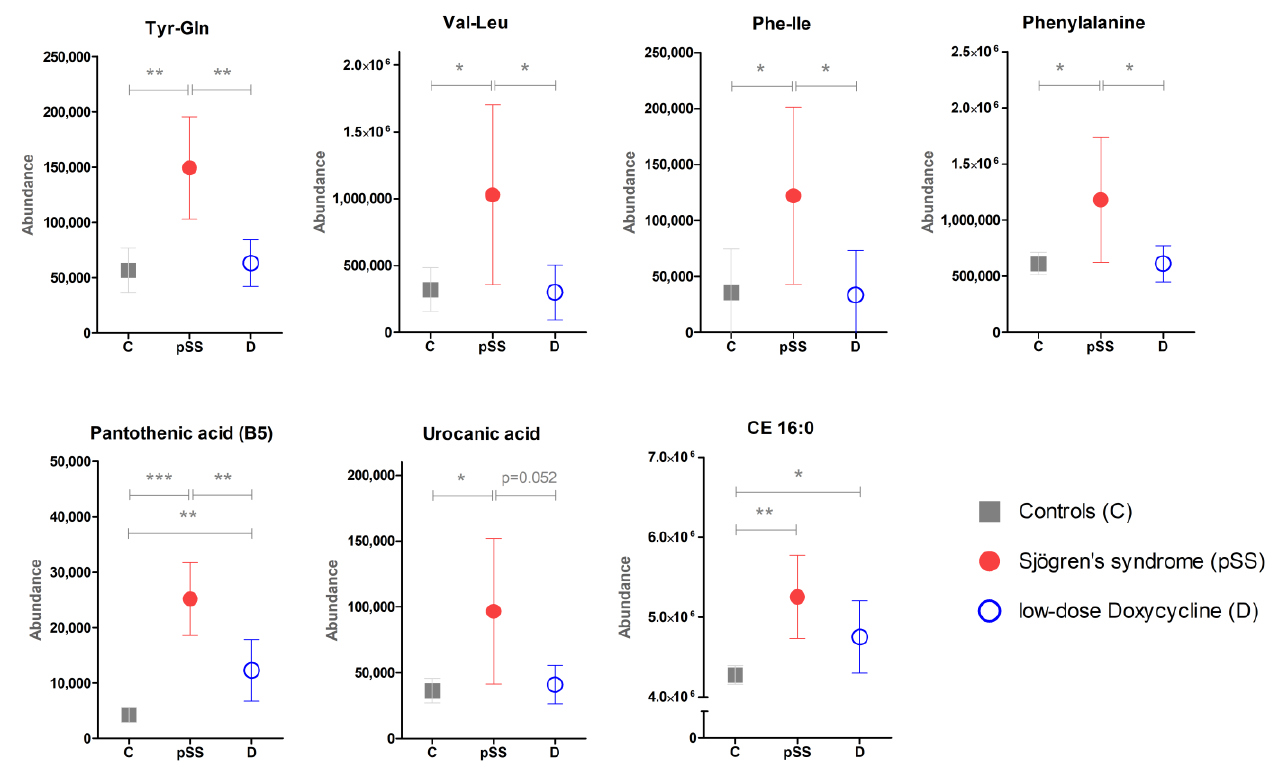
Figure 2. LDD treatment normalized levels of metabolites in the saliva samples of patients with Sjögren’s syndrome. Several metabolites were altered in the saliva samples of patients with pSS when compared to the saliva samples from HC. LDD treatment normalized levels of some, but not all, of these metabolites closer to levels seen in HC. Mean ion abundance with 95% confidence intervals is shown. Legend: CE 16:0, cholesteryl palmitic acid; Phe-Ile, phenylalanine isoleucine dipeptide; Tyr-Gln, Tyrosine glutamine dipeptide; Val-Leu, Valine leucine dipeptide; *, p < 0.05; **, p < 0.01; ***, p < 0.001.